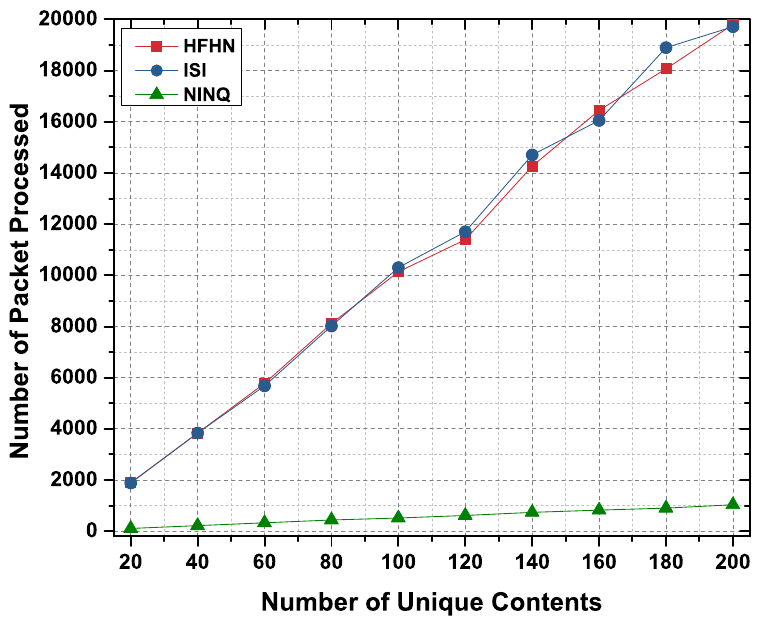
Figure 13. Number of packets processed in a network by number of unique content